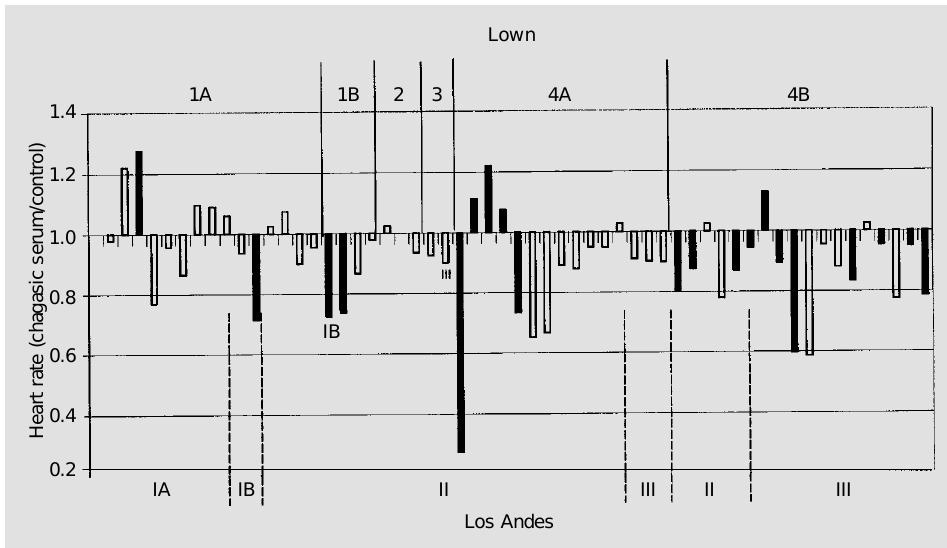
Figure 1 - Classification of chronic chagasic patients and ef- fects of their sera on heart rate and atrioventricular conduction in isolated rabbit hearts. The re- sults were listed according to the Lown classification of the pa- tients as indicated at the top of the figure. Heart rate ratios higher than 1 indicate an in- crease in heart rate and ratios lower than 1 indicate a decrease in heart rate in the presence of serum. Black bars indicate induc- tion of atrioventricular conduc- tion block by serum. Patient clas- sification according to the Los Andes criteria is shown at the bottom of the figure. All sera were tested diluted in Tyrode saline at